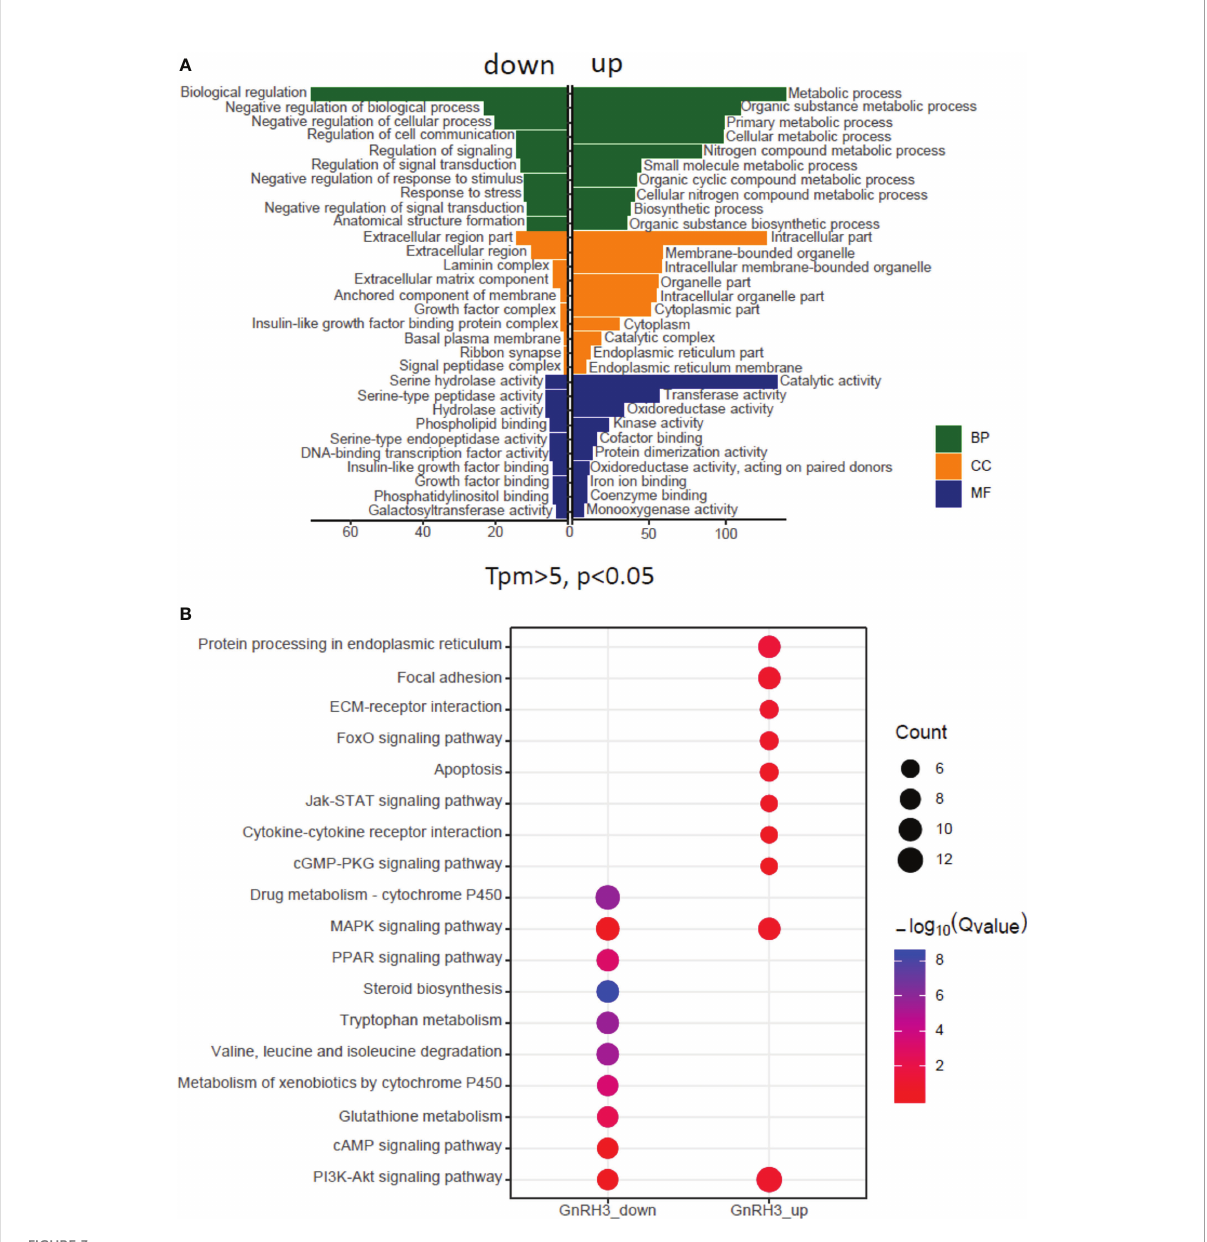
FIGURE 3 Gene Ontology (GO) analysis and Kyoto Encyclopedia of Genes and Genomes (KEGG) analysis based on transcriptome. (A) GO analysis revealed that the selected DEGs which satis fi ed the conditions of TPM >5, FDR <0.05, FC >1.5, or FC <0.7 were made up of three parts, namely, cellular component (CC), biological process (BP), and molecular function (MF). (B) One hundred sixty-two DEGs were classi fi ed into the top 10 enriched pathways using KEGG analysis which included upregulation and downregulation DEGs. Qvalue, Recalibration of P value. Count, the number of